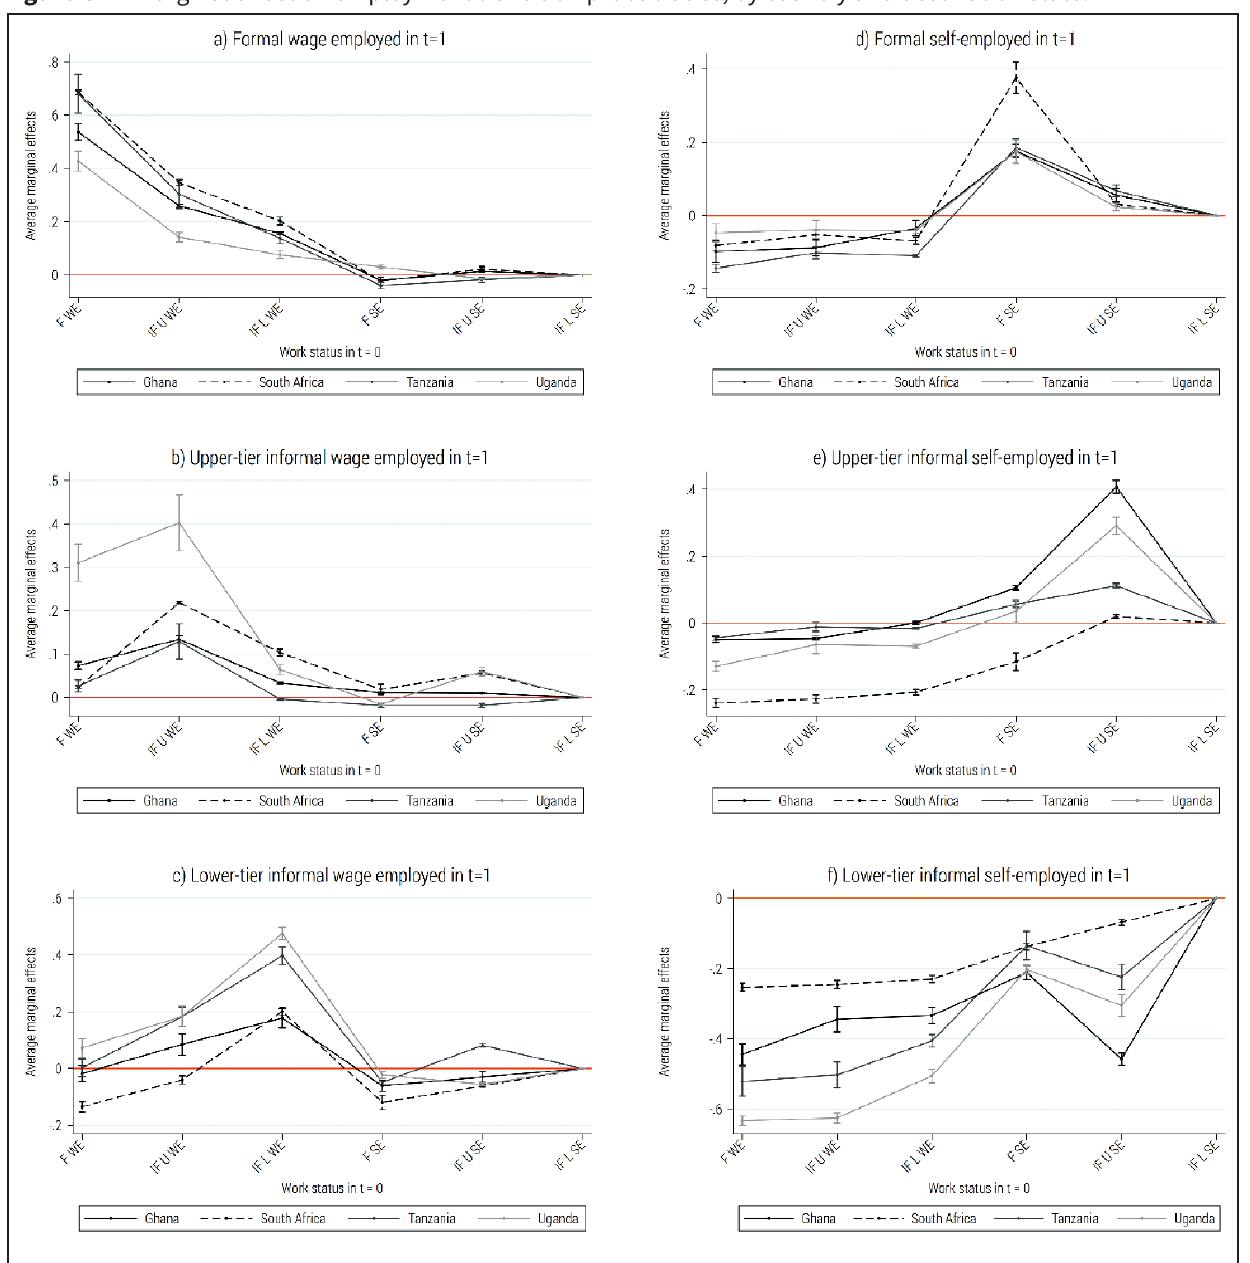
Figure C2 Marginal effect on employment transition probabilities, by country and destination